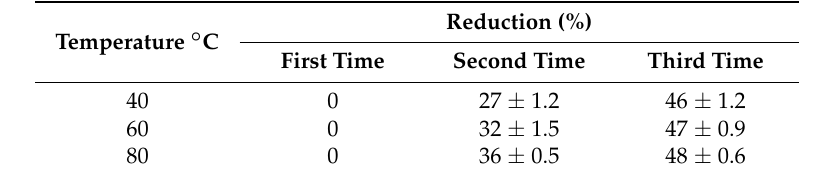
Table 2. Percentage of electrical capacitance reduction of the same gelatin sensor with 38 µm, at temperature range 40, 60, and 80 °C, 90% RH and 868 MHz.